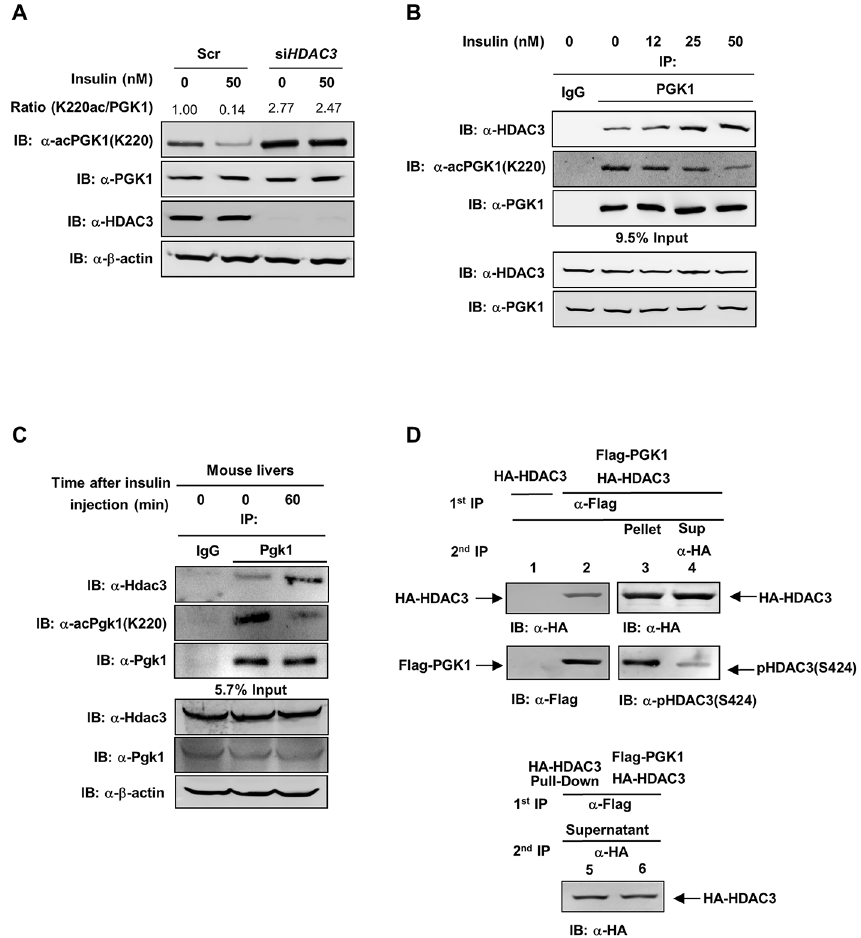
Fig 5. S424 Phosphorylation of HDAC3 promotes its binding with PGK1. ( A ) HDAC3 knockdown prevents the effect of insulin on changing PGK1 K220 acetylation and enzyme activity. HEK293T cells were transiently transfected with siRNAs against HDAC3 . At 48 hr post transfection, cells were treated with 50 nM insulin for 2 hr. “ Scr ” denotes scramble siRNA control. The K220 acetylation level of endogenous PGK1 was determined by western blot, and then normalized against endogenous PGK1. ( B ) Insulin enhances PGK1 interaction with HDAC3. HEK293T cells were treated with insulin at the indicated concentrations for 2 hr. PGK1 protein was immunoprecipitated and followed by western blot to detect the K220 acetylation and interaction with HDAC3. The phrase “ 9.5% input ” refers to the fact that 9.5% of total proteins for IP experiments were loaded. ( C ) Insulin increases Pgk1 K220 acetylation and interaction with Hdac3 in mouse livers. Insulin (5 U/kg) was intraperitoneally injected into wild-type mice. At the indicated time points post injection, mouse livers were harvested, and the Pgk1 K220 acetylation and interaction with Hdac3 were determined by western-blot. The phrase “ 5.7% input ” refers to the fact that 5.7% of total proteins for IP experiments were loaded. ( D ) Ser424 phosphorylated HDAC3 preferentially interacts with PGK1. HA-HDAC3 was transiently transfected with or without Flag-PGK1 into HEK293T cells. Cell lysates were immunoprecipitated with Flag antibody as indicated by first IP Ppt. The remaining supernatant (Sup) was precipitated with HA antibody (second IP). An equal amount of HA-HDAC3 from the first Flag-PGK1 co-IP or the second HA-HDAC3 IP was used to detect Ser424 phosphorylation with the phosphoSer424 antibody (as indicated by P-HDAC3(S424)). Supporting information can be found in S7, S8 and S9